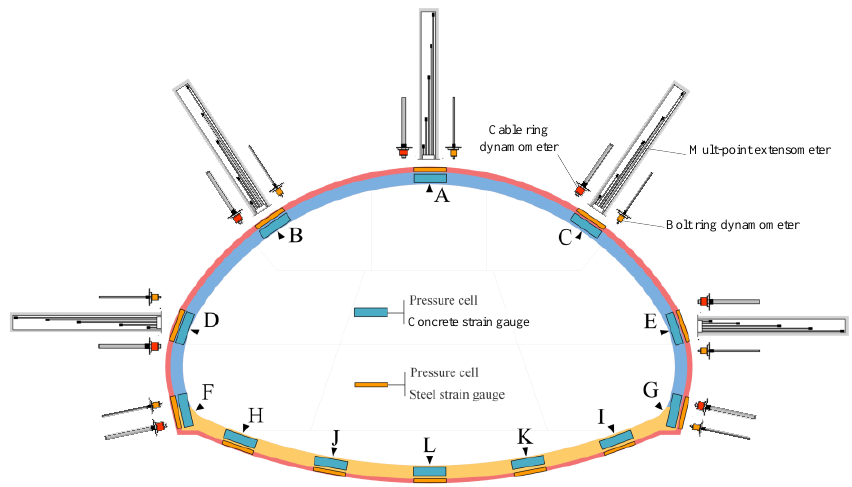
Figure 11. Layout of the monitoring points.